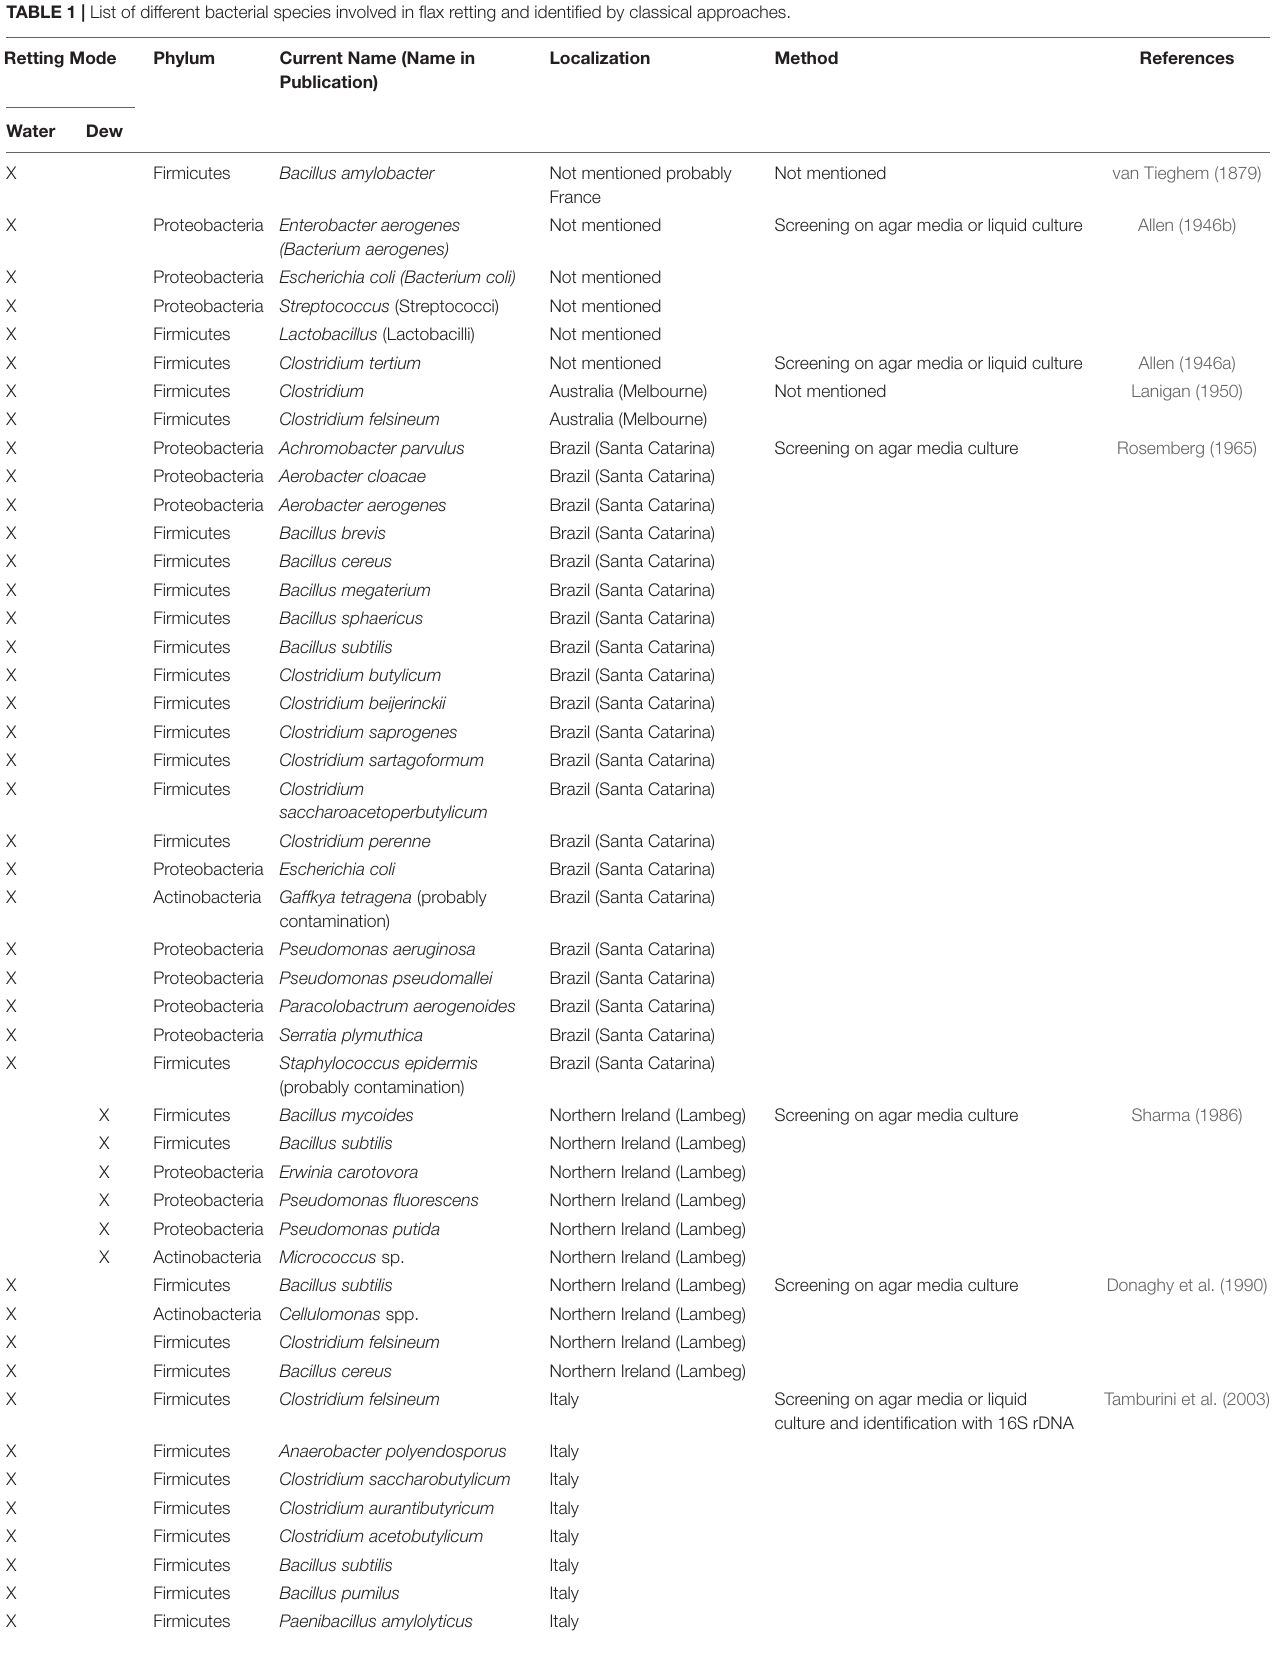
TABLE 1 | List of different bacterial species involved in flax retting and identified by classical approaches. Retting